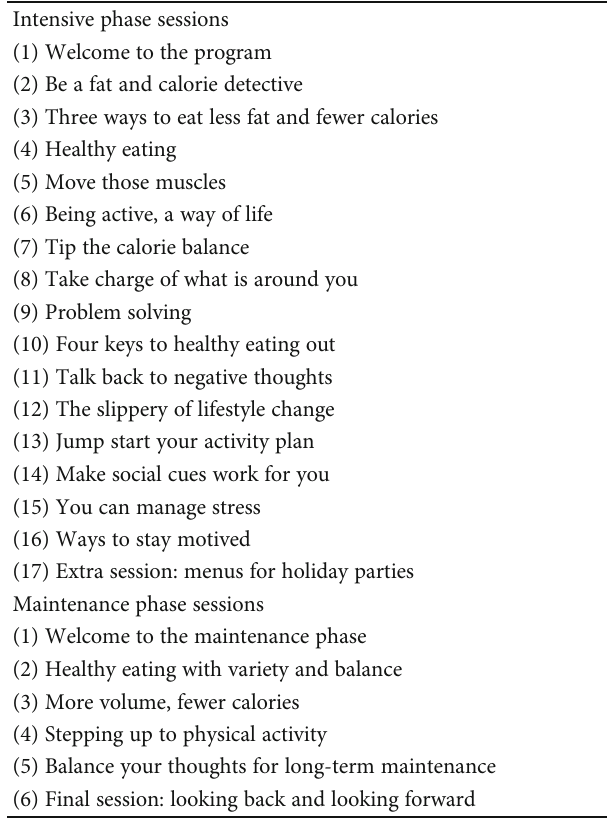
Table 1: Sessions of the PREVISY with obesity and diabetes